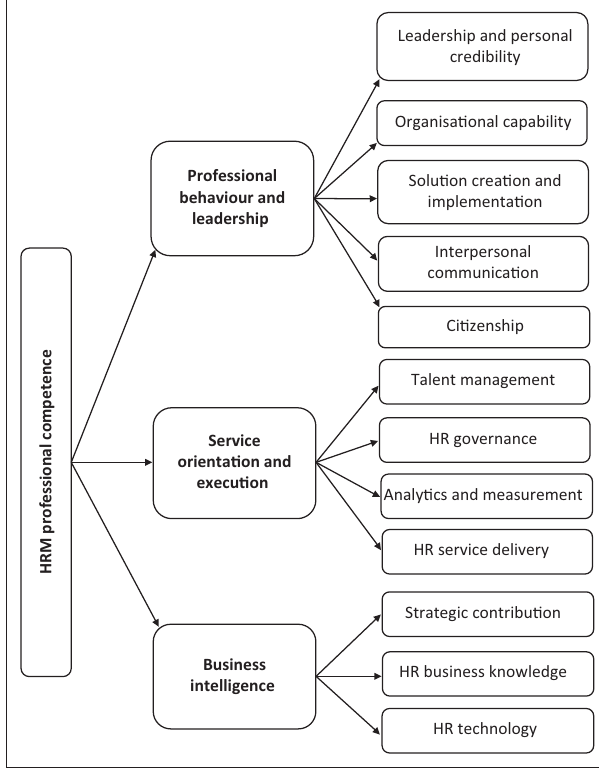
FIGURE 1: Human resource professional competence